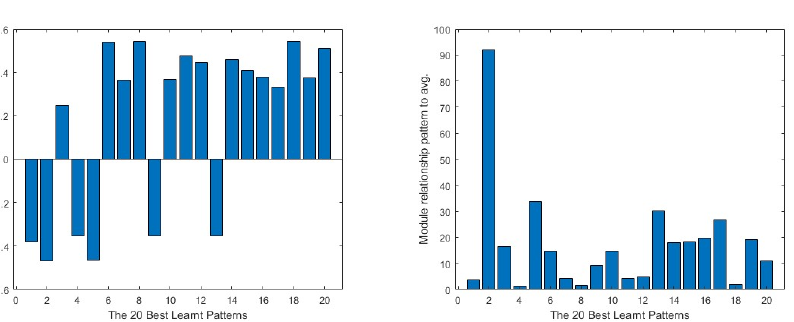
(cid:12) (cid:12) (cid:3339) ∂ Loss µ (cid:12) (cid:12) (cid:4698) relationship to the average (cid:12) (cid:12) ∂ W n (cid:3105)(cid:3024) (cid:3289)